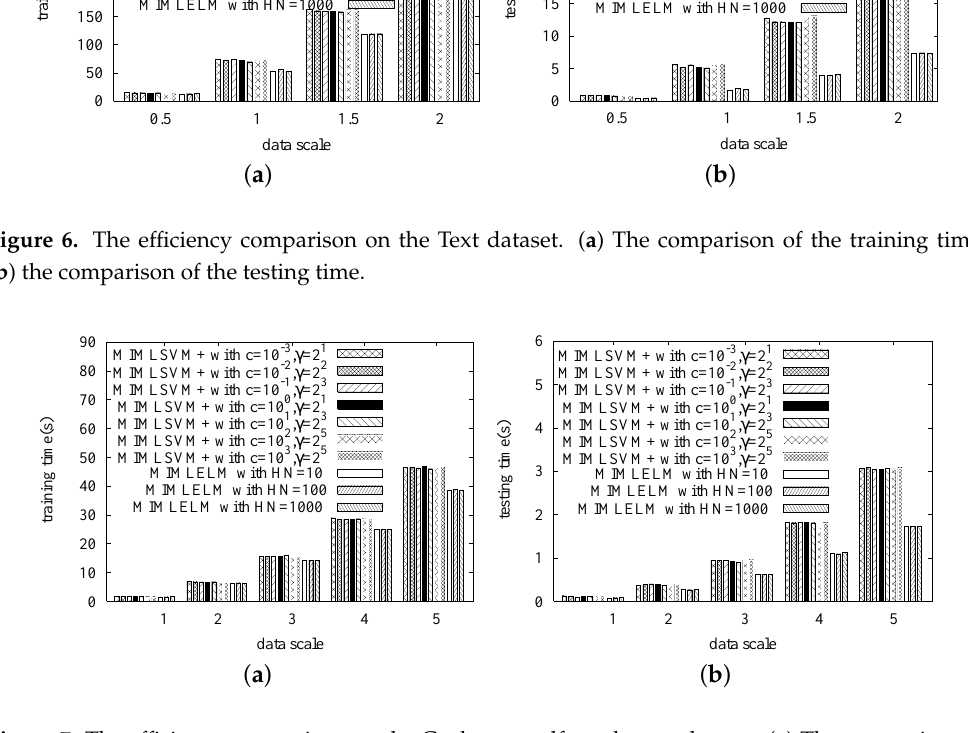
Figure 7. The efficiency comparison on the Geobacter sulfurreducens dataset. ( a ) The comparison of the training time; ( b ) the comparison of the testing